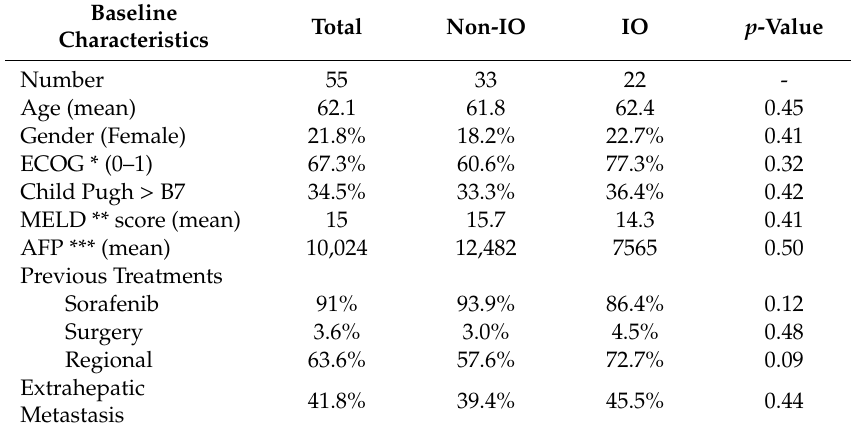
Table 3. Baseline characteristics of the HCV-positive HCC patients (comparing patients who received second-line non-IO versus